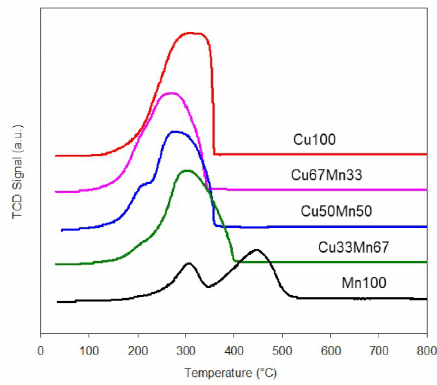
Figure 3. H 2 -TPR profiles of Cu-Mn oxide samples.